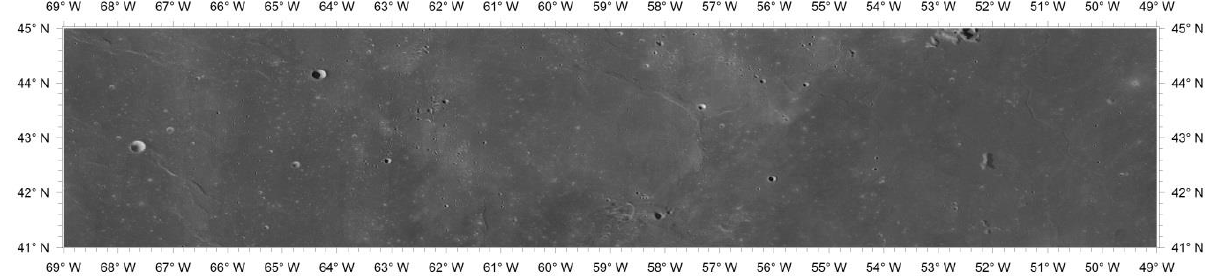
Figure 6. Zooming-out view of the resultant seamless DOM mosaic of Chang’e-5 landing